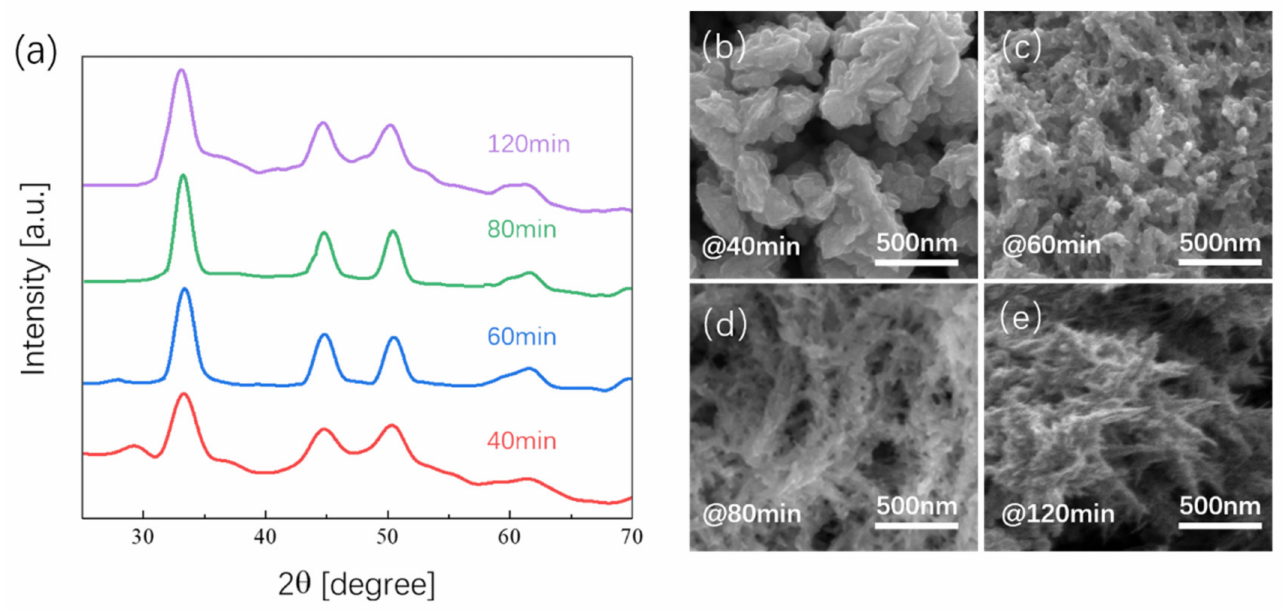
Figure 1. ( a ) XRD pattern of Ni x Se y with different aging times; ( b – e ) SEM images of Ni x Se y with different aging